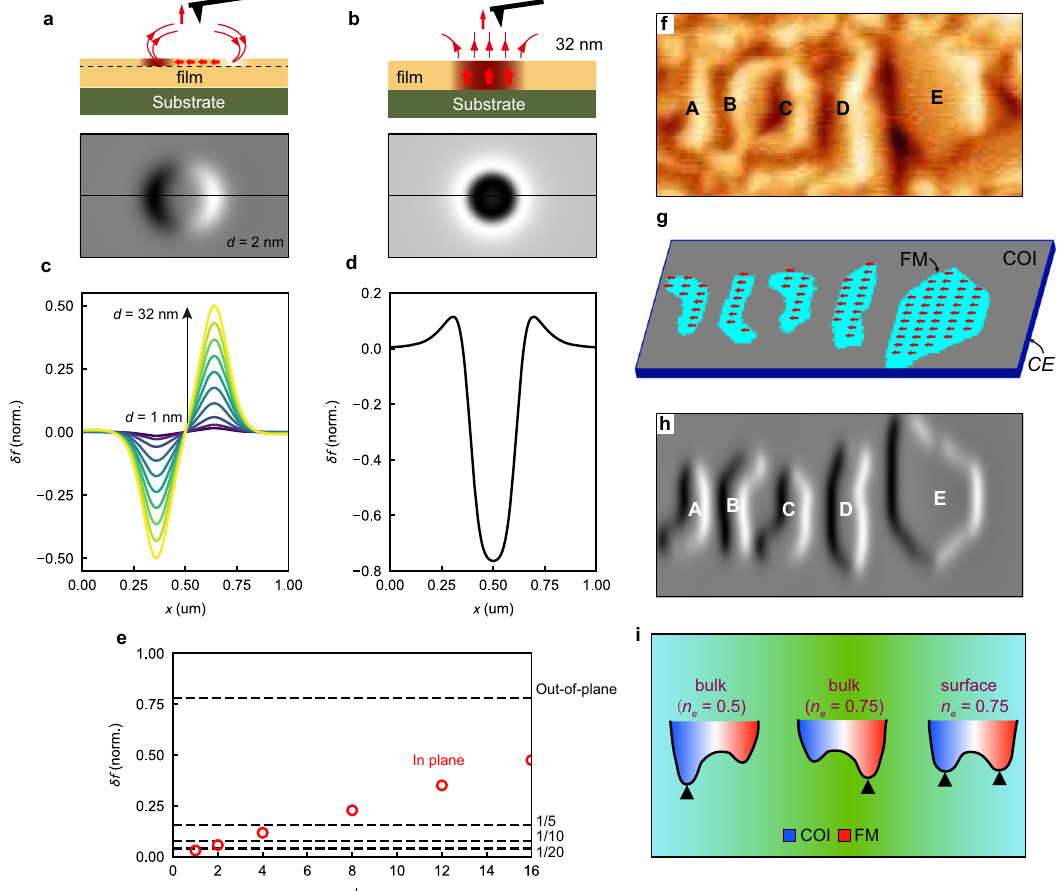
Fig. 5 Simulation of the magnetic images. a – b Simulated magnetic images of in-plane and out-of-plane magnetic domains. Size of simulated image: 1 × 0.6 μ m 2 . The domain with 2 nm thickness is shown in a . Both domains have a diameter of 300 nm. c The thickness dependence of the pro fi les along the horizontal line across the center of domains. d Pro fi le along the line in b . All the pro fi les in c and d are normalized by the same factor. e The thickness dependence of the contrast magnitude of in-plane magnetic domains (red open circles). The dashed line is the contrast of out-of-plane magnetic domains divided by a factor of 1, 5, 10, and 20. f A zoom-in of the surface phase separation pattern. Several large FM phase domains are marked with A , B , C , D , and E . g Illustration of the net magnetic moments at the surface. h Simulated MFM image of FM phase domains ( A – E ) based on the magnetic moment distribution shown in g . i Schematic showing how the ground state changes with the charge density and